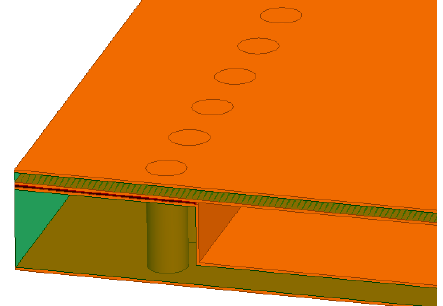
Figure 22. Section of the empty SIW. FR4 substrates (green), Prepreg (dark red), and copper (orange).